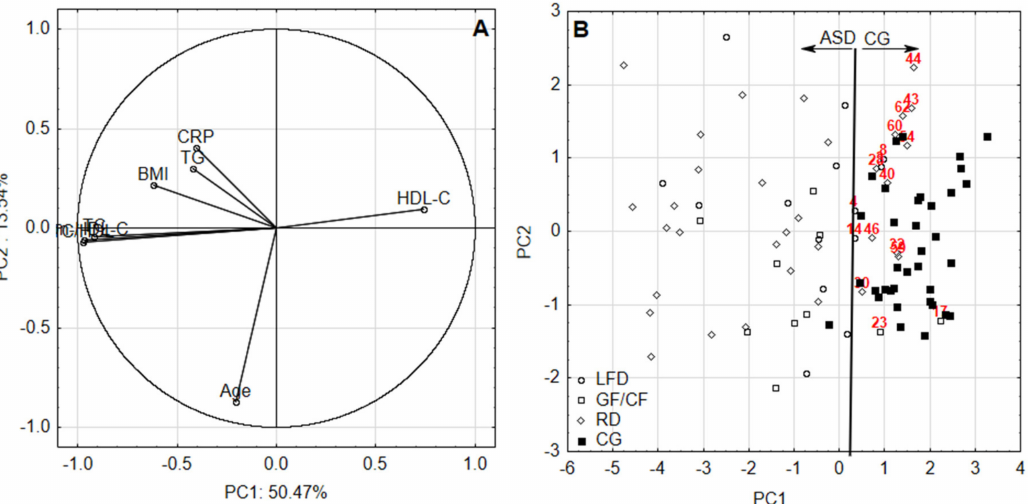
Figure 2. ( A ) The first principal component (PC1) and the second principal component (PC2) and ( B ) scores for second data